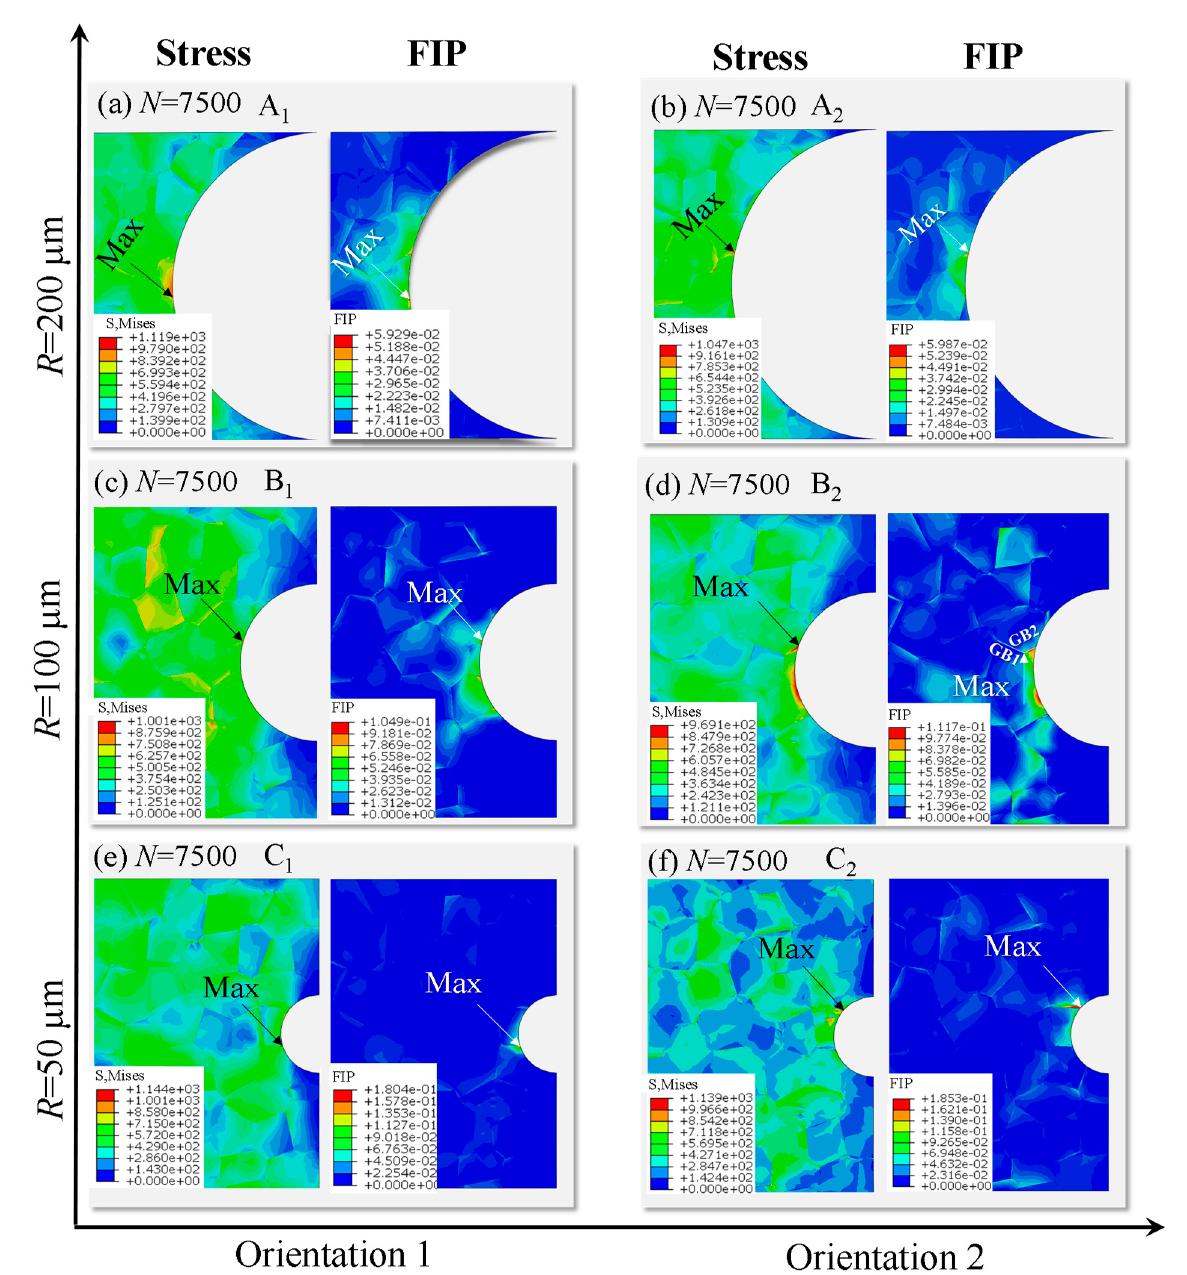
Figure 6. Distributions of von Mises stress and acumulative equivalent plastic strain FIP p ( a ) Model A 1 ( R = 200 μ m, Orientation 1); ( b ) Model A 2 ( R = 200 μ m, Orientation 2); ( c ) Model B 1 ( R = 100 μ m, Orientation 1); ( d ) Model B 2 ( R = 100 μ m, Orientation 2); ( e ) Model C 1 ( R = 50 μ m, Orientation 1); ( f ) Model C 2 ( R = 50 μ m, Orientation 2).